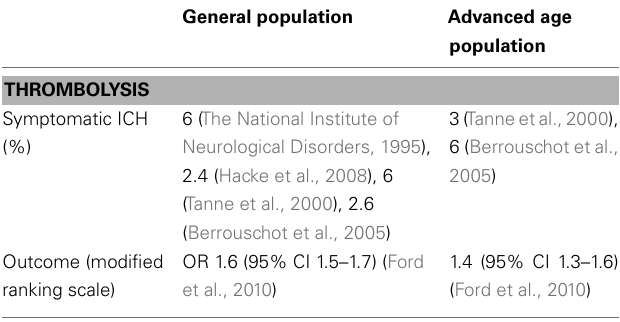
Table 1 |Thrombolysis in general and advanced age populations.